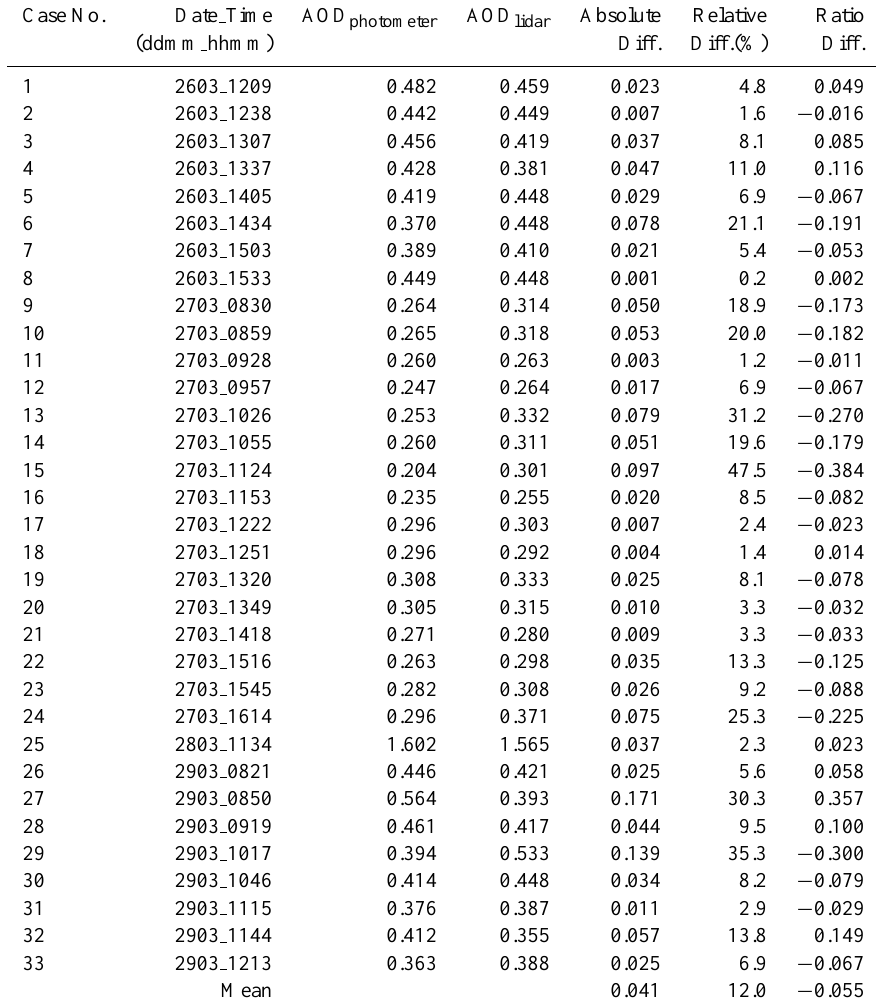
Table 3. A comparison of AOD derived by lidar and sunphotometer Absolute Difference= | AOD photometer –AOD lidar | Relative Difference= | AOD photometer –AOD lidar | /AOD